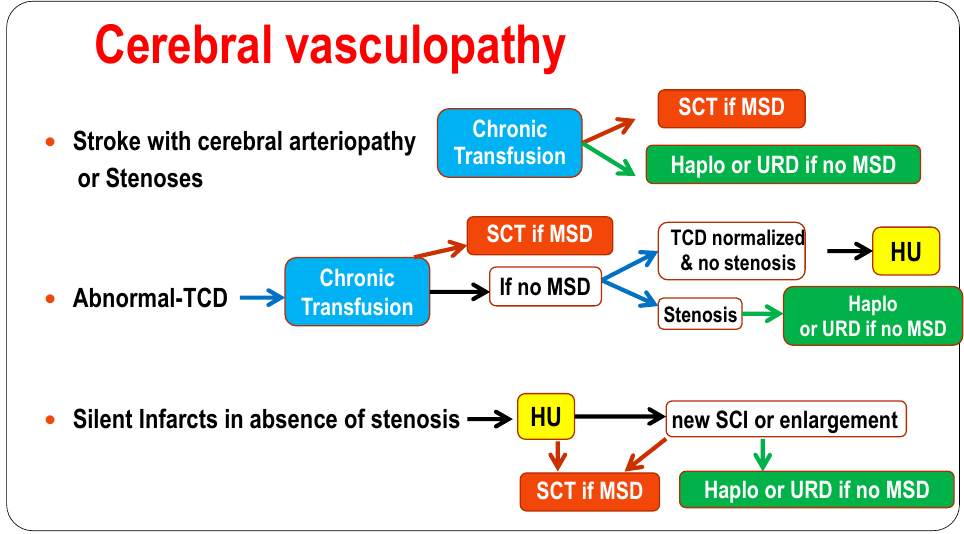
Figure 3. Indications of the different treatments: hydroxyurea, chronic transfusion and. type of SCT to recommend in children with cerebral vasculopathy. Abbreviations: HU = hydroxyurea, MSD = matched-sibling donor, SCT = stem cell transplantation, Haplo = related haplo-identical, URD = unrelated stem